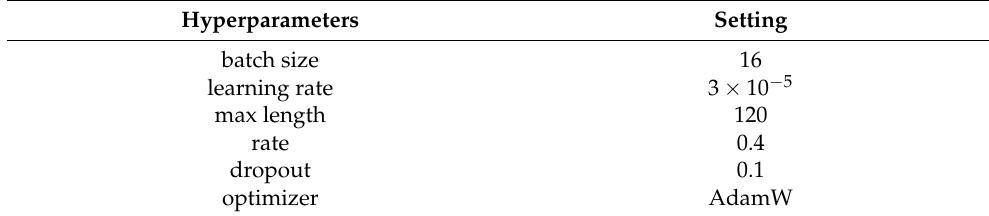
Table 2. Some important hyperparameter settings for ATE and ASC